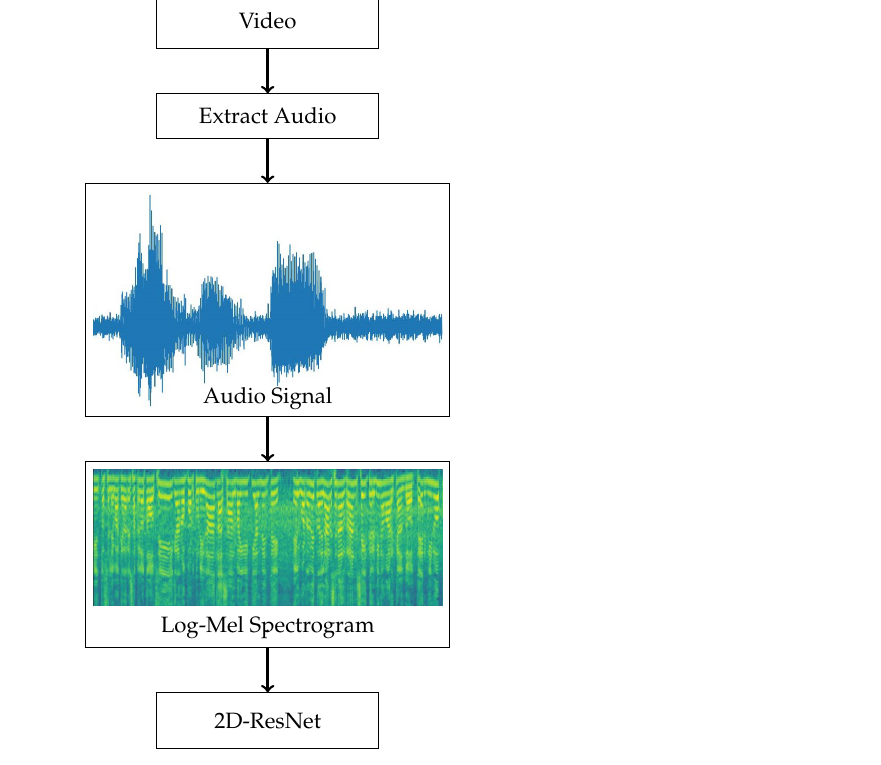
Figure 5. Illustration of the pipeline used by the audio-based model. First, audio is extracted from the video. The audio is used to compute Log-Mel spectrograms, which are then used as inputs to a